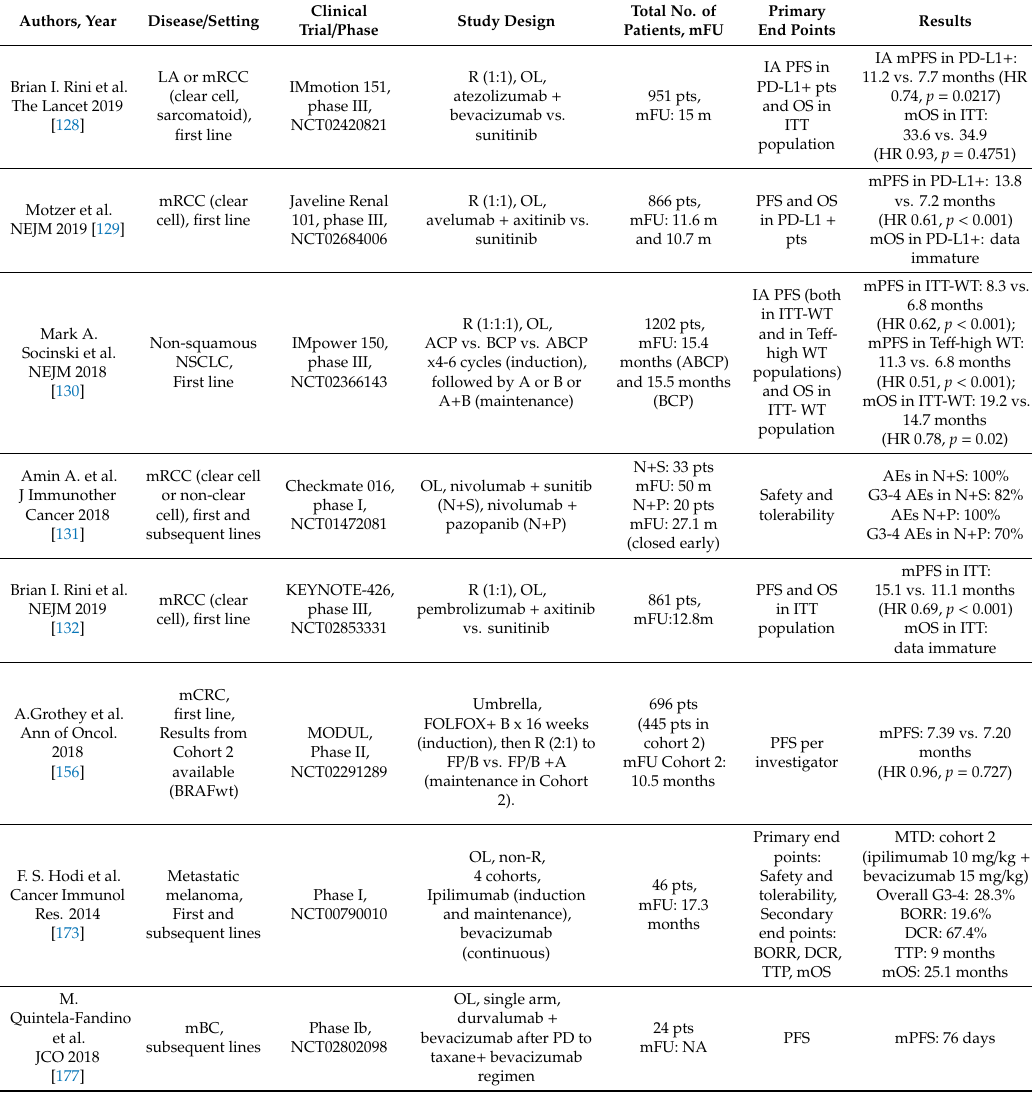
Table 1. Clinical trials combining immunotherapy and